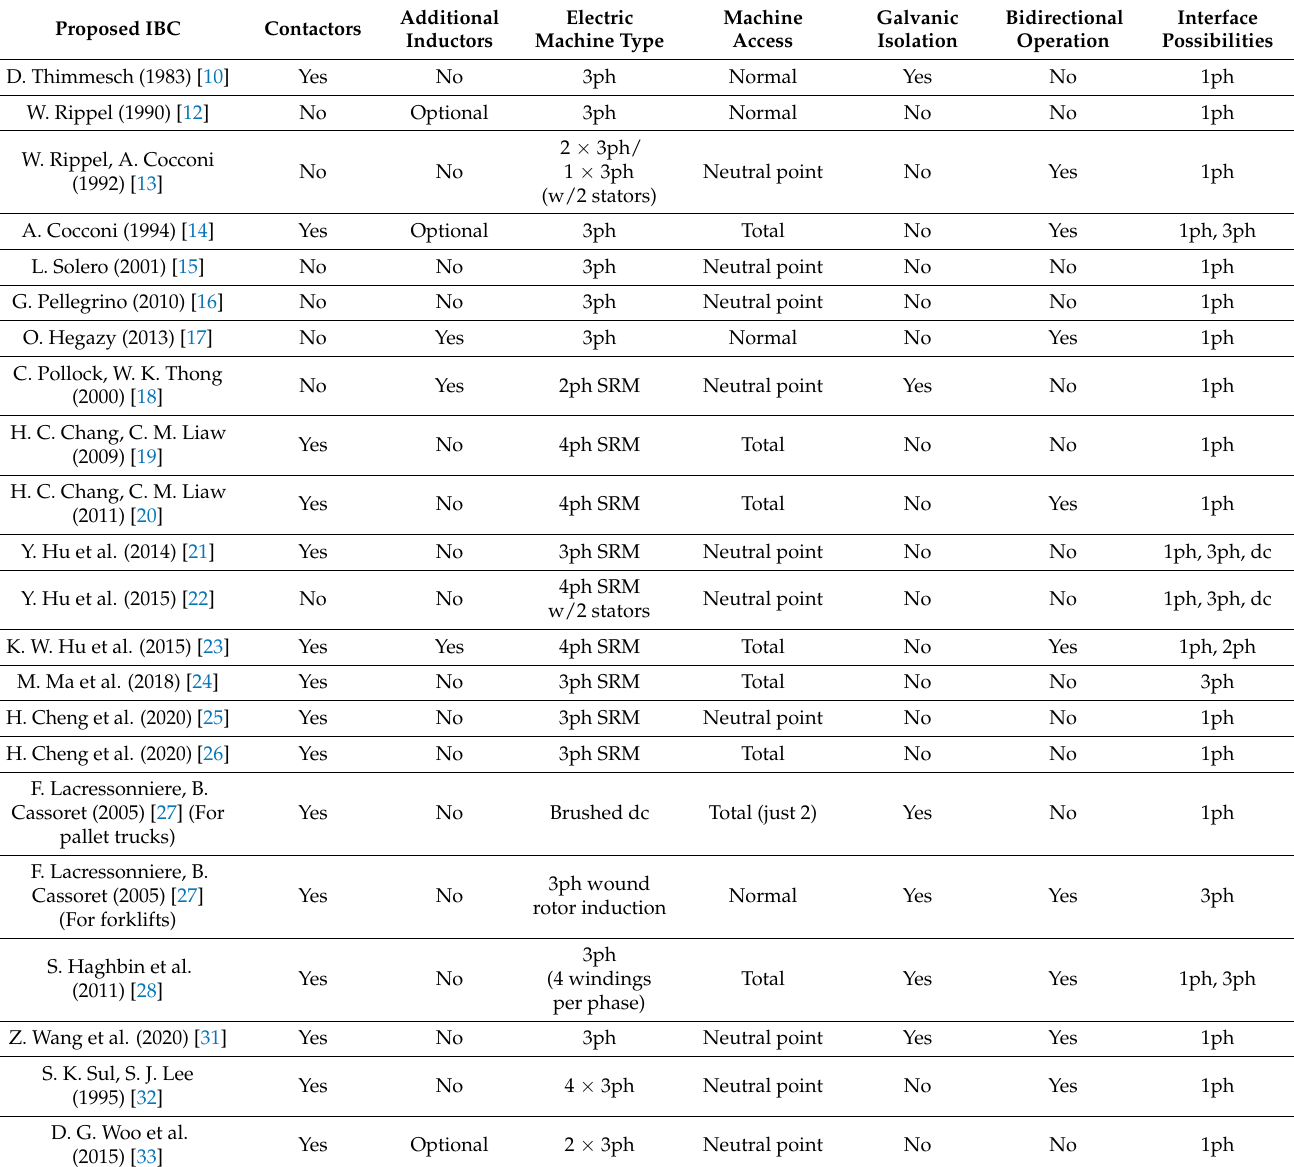
Table 1. Qualitative comparison between the presented